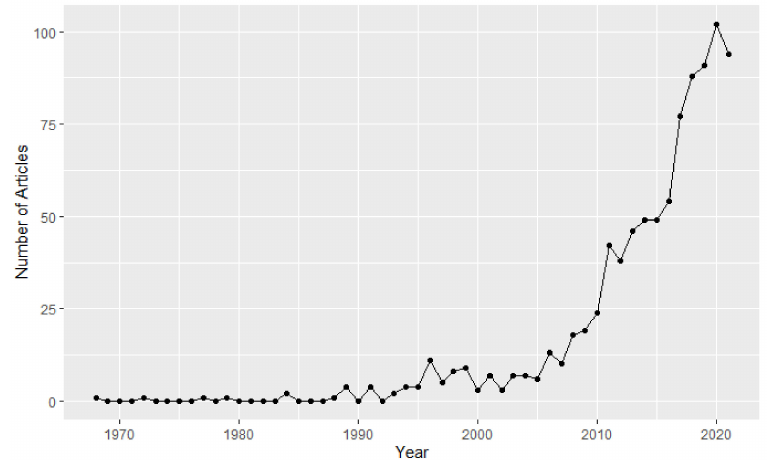
Figure 1. Annual scientific production from 1968 to